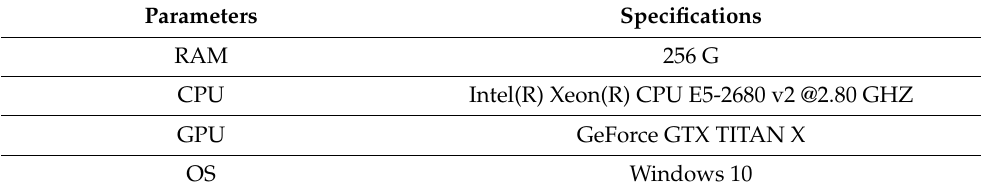
Table 1. Server configuration information.